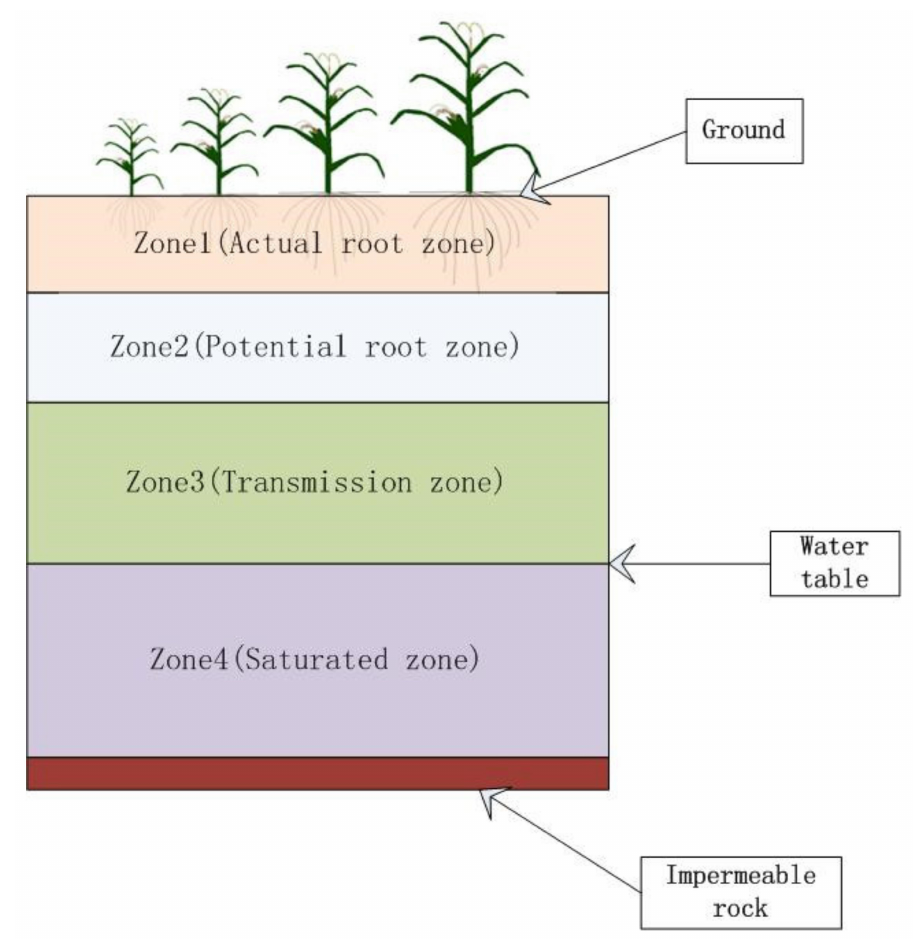
Figure A3. Schematic of the soil profile used in the